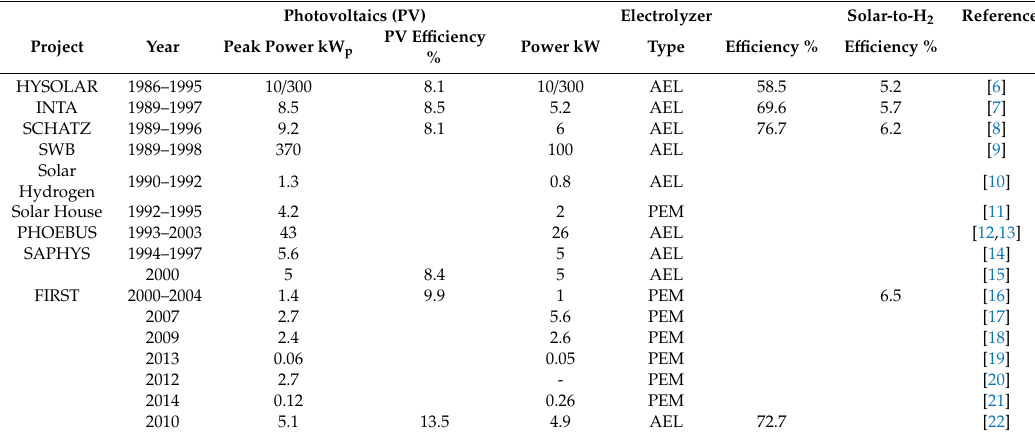
Table 1. List of demonstration systems developed in the last 30